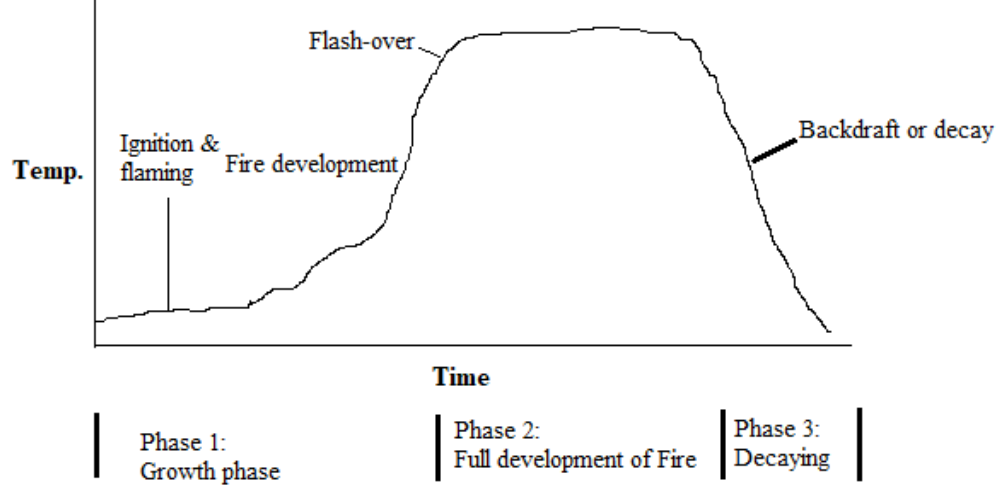
Figure 4. Different phases of fire in natural fiber. Redrawn with permission from Schartel, Hull [136] and Väisänen